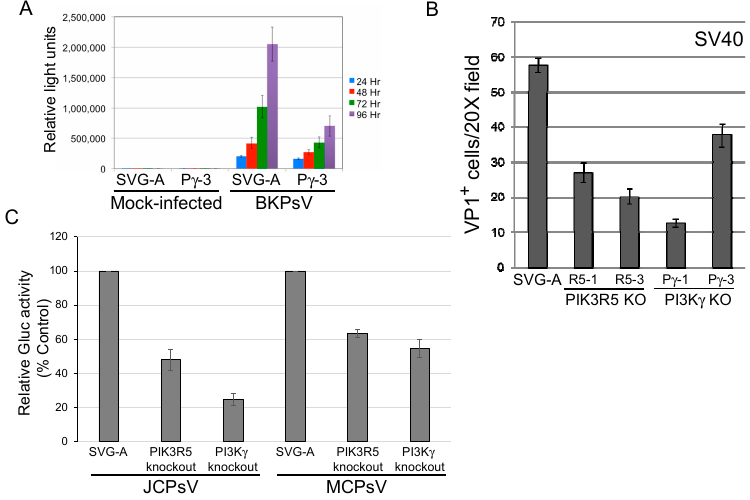
Figure 4. PI3K γ pathway facilitates infection by other polyomaviruses. ( A ). Parental SVG-A cells and PI3K γ knockout (clone P γ -3) cells were mock-infected or infected with BKPsV expressing secreted Gaussia luciferase. At the indicated times after infection, luciferase activity in the culture medium was measured and expressed as relative light units. Results show average plus and minus standard deviation of triplicate measurements, and are representative of multiple di ff erent experiments. ( B ). Parental and knockout SVG-A cells were infected with SV40. Three days post-infection, cells were fixed and immunostained for intracellular VP1. VP1 positive cells were counted by indirect immunofluorescence. Results show average and standard error of multiple experiments. ( C ). Parental SVG-A cells or PIK3R5 or PI3K γ knockout cells were infected for 1 h at 4 ◦ C with JCPsV-Gluc or MCPsV-GLuc. Three days post-infection, luciferase activity in the culture medium was measured. Graph shows average results of triplicate infections plus and minus standard deviation, expressed as activity normalized to cells without